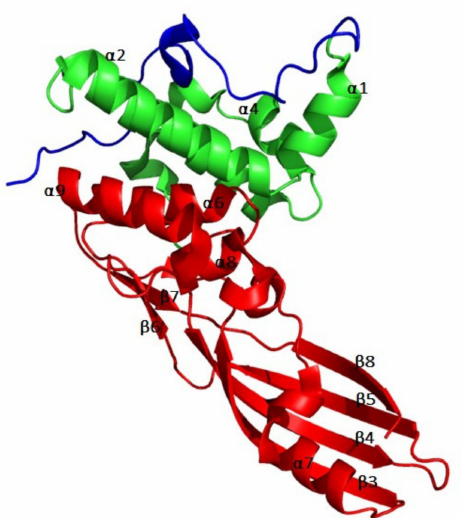
Figure 2. 3D structure of colicin M. The three domains of the protein are colored differently, according to [26]: blue for the translocation domain, green for the reception domain, and red for the catalytic domain. Secondary structure elements are numbered according to their order of appearance within the primary structure of the protein. The figure was prepared with the atomic coordinates from the PDB (PDB entry: 2XMX) by using PyMOL (DeLano